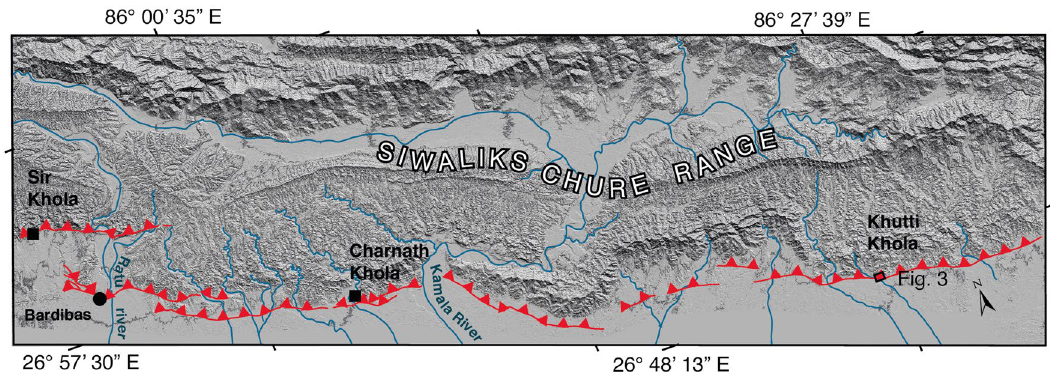
Figure 2. Map of the Main Frontal Thrust strands (red), between the Sir and the Khutti Khola rivers based on ALOS 5 m resolution digital elevation model. Small black boxes locate the sites studied in the area. ALOS 5 m DEM. Figure generated with ENVI Classic (https:// www. l3har risge ospat ial. com/ Softw are- Techn ology/ ENVI), Adobe illustrator CC (http:// www. adobe. com/ fr/ produ cts/ illus trator. html) and MAPublisher 10.8.1.789.